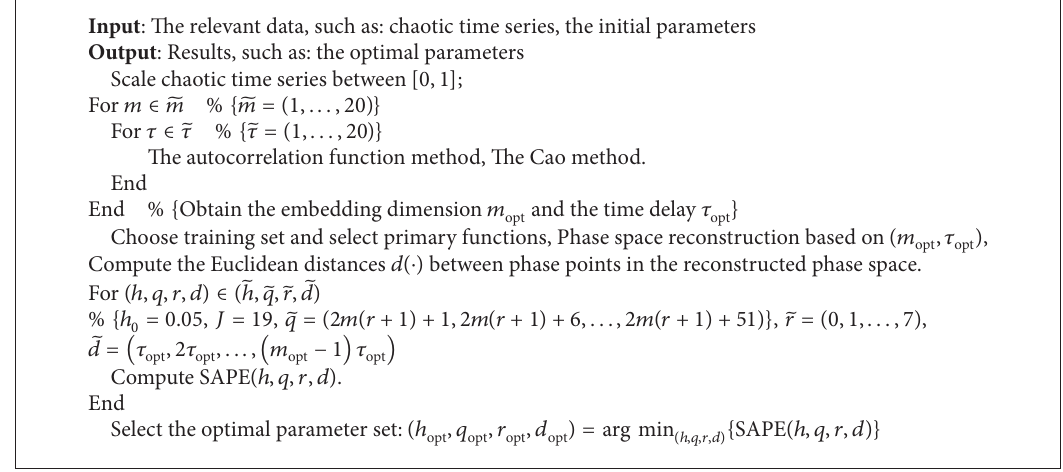
Algorithm 1: Searching algorithm for optimal parameter set.